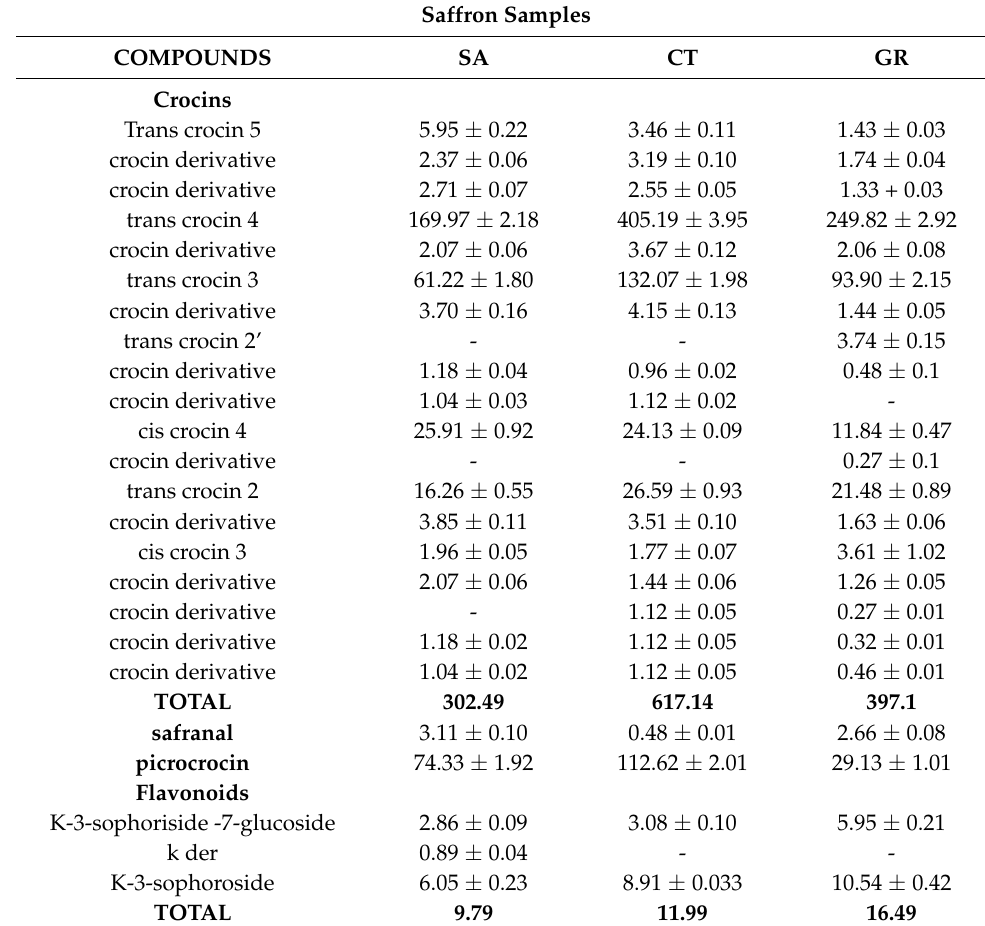
Table 1. Second metabolites content of dried stigmas of SA, CT, GR saffron samples. Average value ± SD (standard deviation)of three samples. Data are expressed as mg/g sample. SA: Sardinia sample, CT: central Tuscany sample, GR: south Tuscany